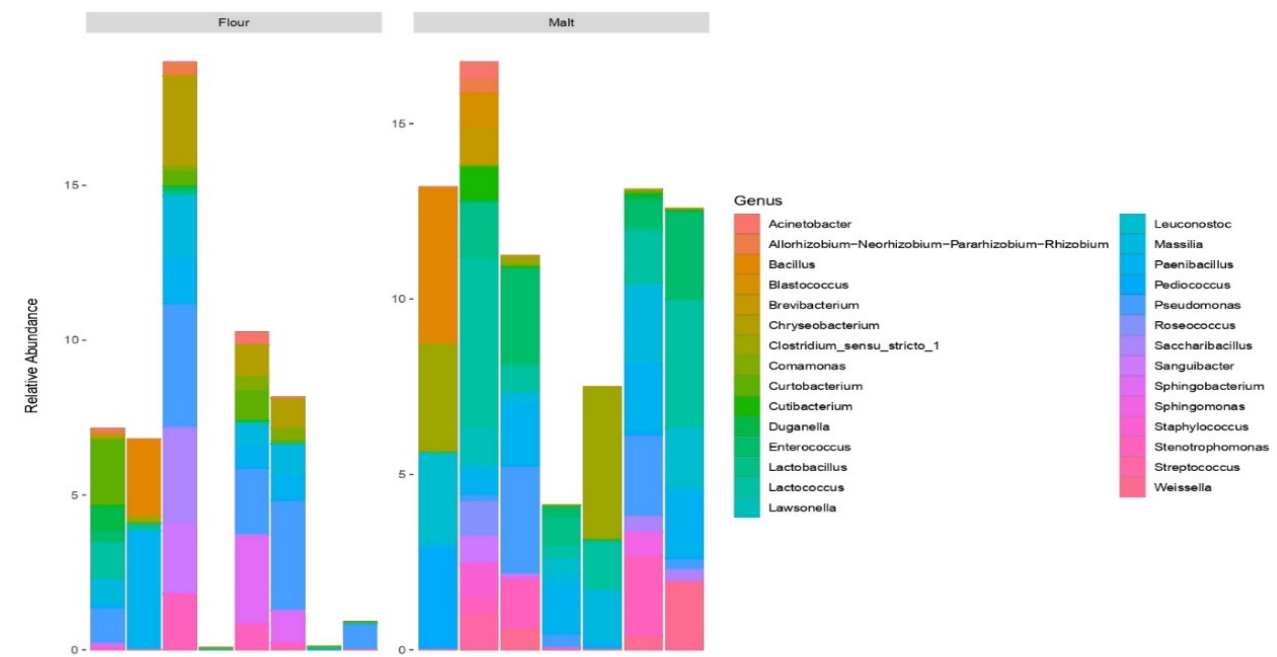
Figure 3. Bacterial taxa at the genus level for flour and malt samples.